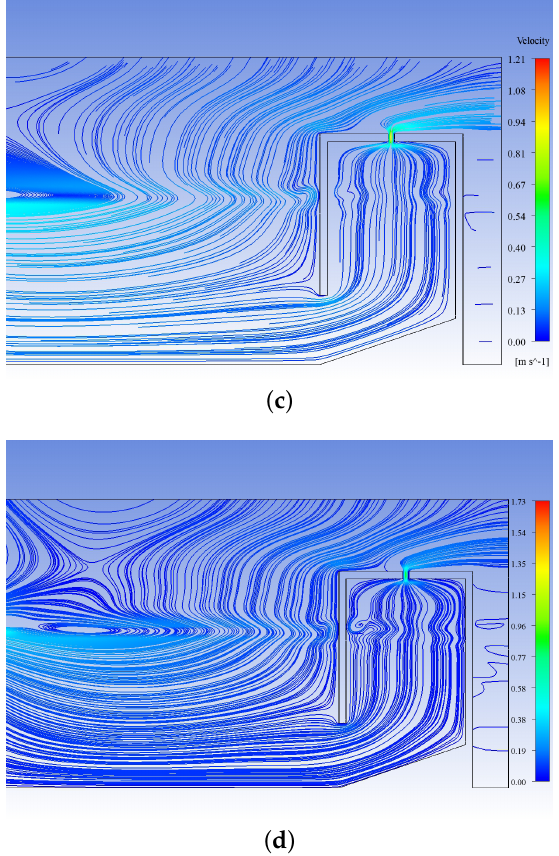
Figure 9. Streamline profile at various time instants: ( a ) t = 120 s, ( b ) t = 150 s, ( c ) t = 170 s, and